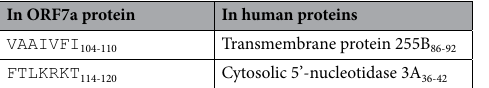
Table 7. Localization of homologous 7-mers in the ORF7a protein and human proteins.